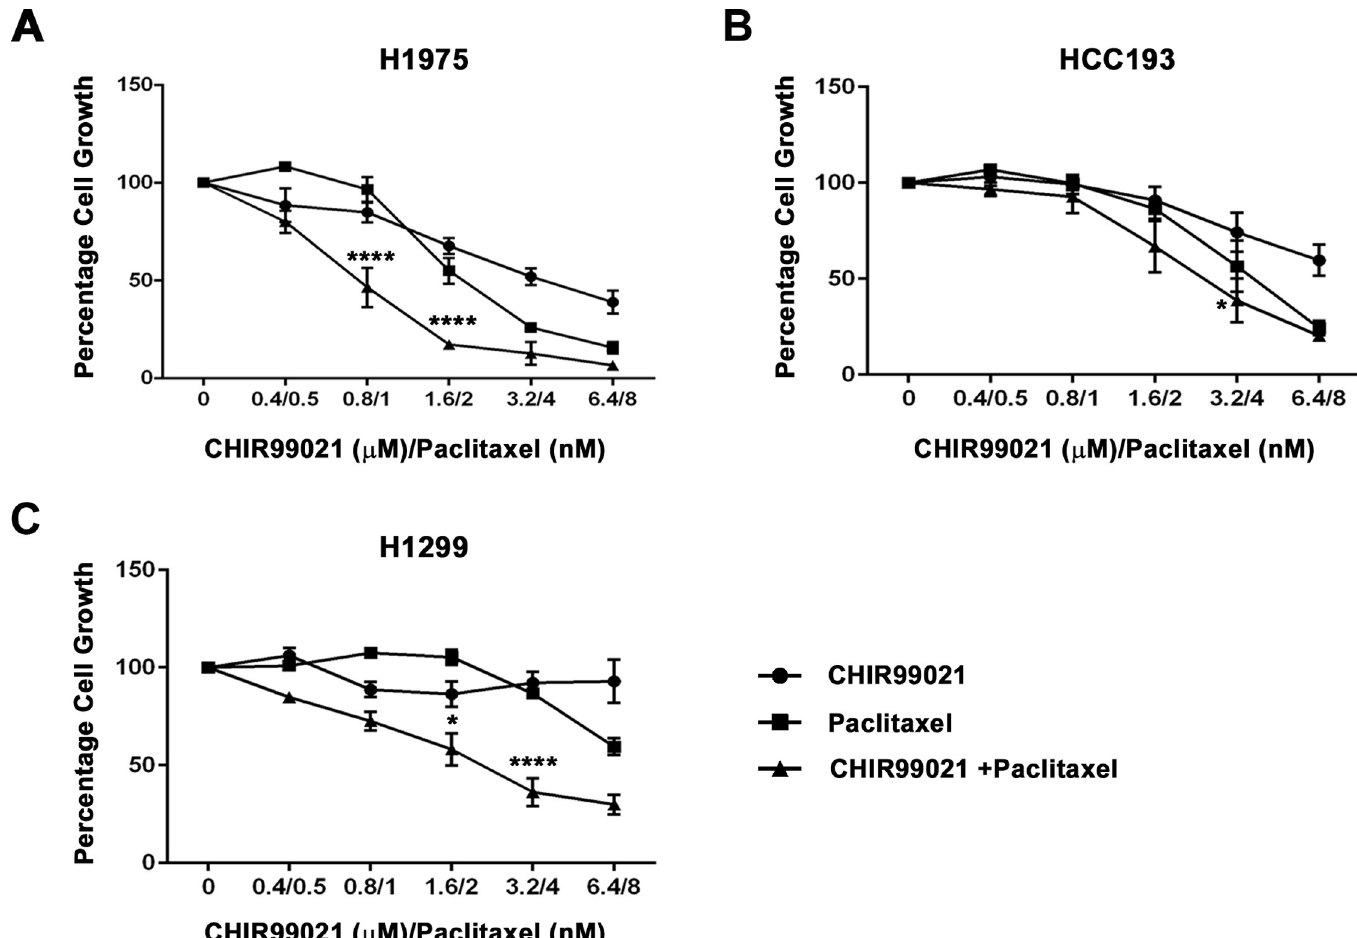
Fig 1. NSCLC cell lines treated with CHIR99021 and paclitaxel, as mono-treatments or in combination, show varying degrees of sensitivity. Cell growth was measured in the following NSCLC cell lines: (A) H1975, (B) HCC193 and (C) H1299. Cells were treated for 96 hours with 2-fold increasing concentrations of CHIR99021 ( μ M), paclitaxel (nM) or CHIR99021 with paclitaxel at a constant ratio of 1:800 paclitaxel to CHIR99021, respectively. A significant reduction in H1975 cell growth was observed when treated with the combined drugs at the following concentrations: 0.8 μ M CHIR99021 + 1 nM paclitaxel ( ���� p < 0.0001, 1nM paclitaxel vs control vs 0.8 μ M CHIR99021) and 1.6 μ M CHIR99021 + 2 nM paclitaxel ( ���� p < 0.0001, 2nM paclitaxel vs control vs 1.6 μ M CHIR99021). Similarly, significant responses were observed in H1299 cells treated with 1.6 μ M CHIR99021 + 2 nM paclitaxel ( � p < 0.05, 2nM paclitaxel vs control vs 1.6 μ M CHIR99021) and 3.2 μ M CHIR99021 + 4 nM paclitaxel (